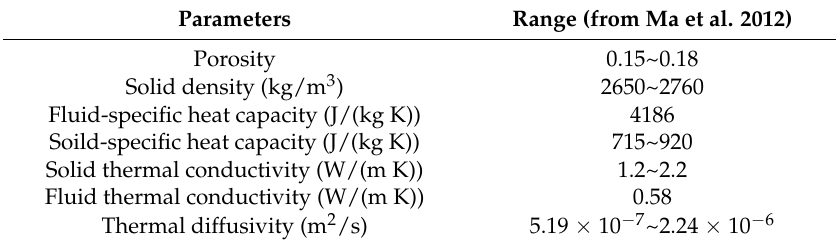
Figure 8. The range of fluxes (i.e., the 5th and 95th percentiles) estimated by the proposed model compared with the Darcy’s Law-based fluxes at Spring 9 at daily ( A ) and half-hourly ( B ) time scales. Table 1. Ranges of physical parameters used to generate parameter sets in the model.